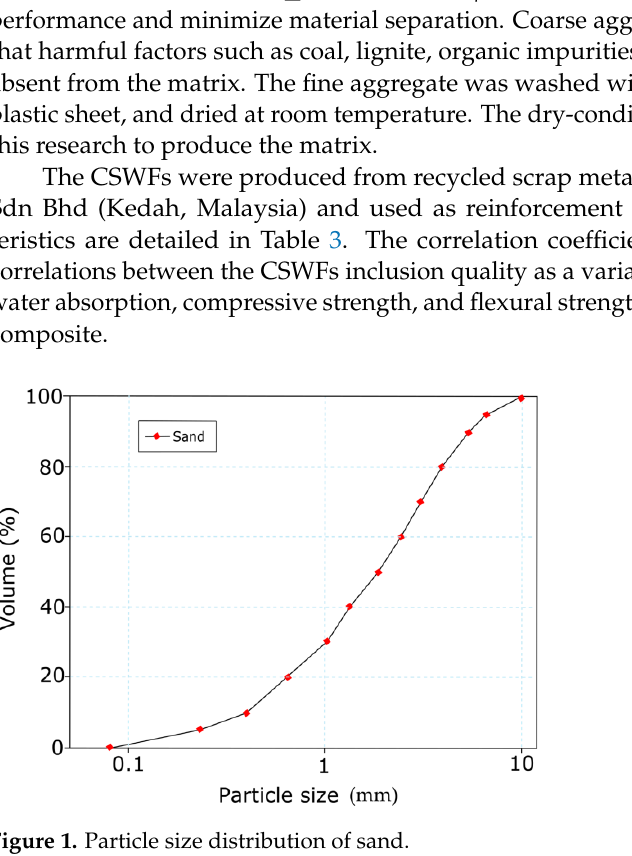
Table 3. The specifications of CSWFs used.